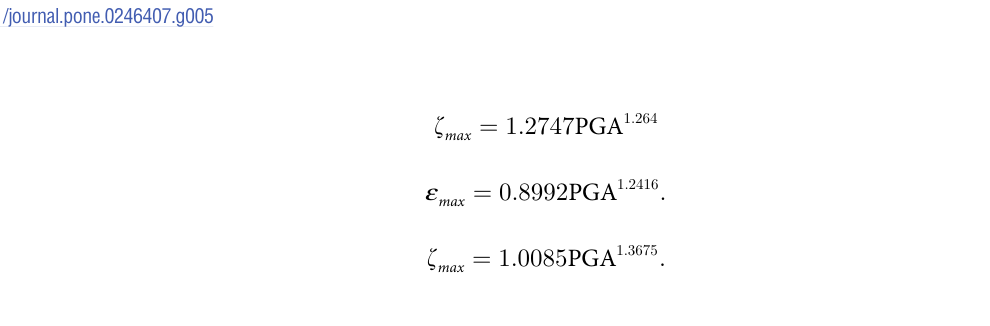
Fig 5. IDA results.